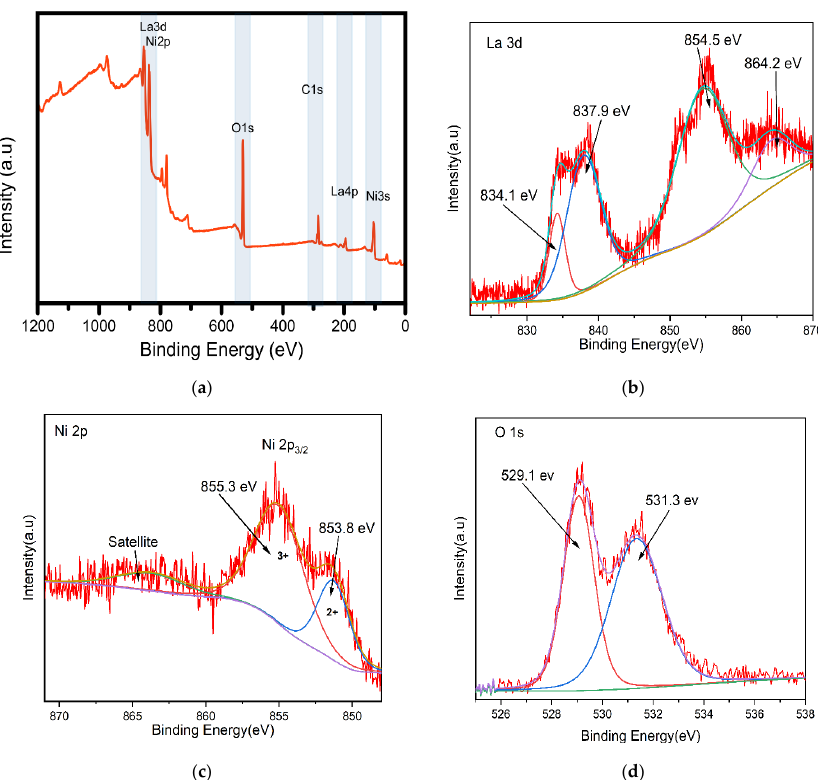
Figure 6. XPS spectra of LaNiO 3 for 1:1 ratio, ( a ) full range survey, ( b ) La3d, ( c ) Ni2P and ( d ) O1s spectra.